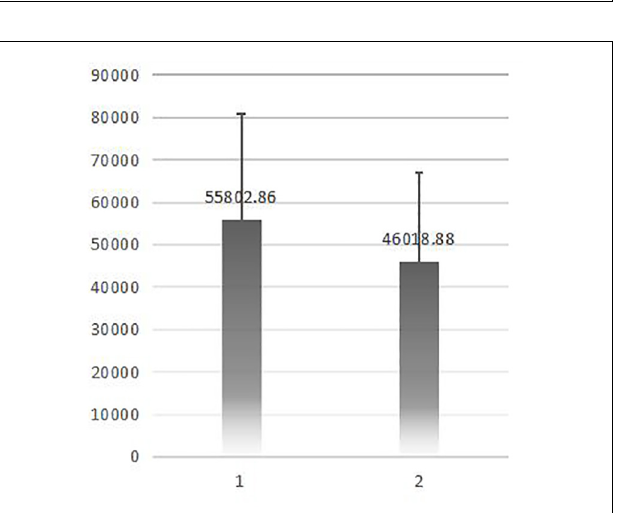
FIGURE 4 | A comparison of cost between the groups. (The vertical axis is in RMB